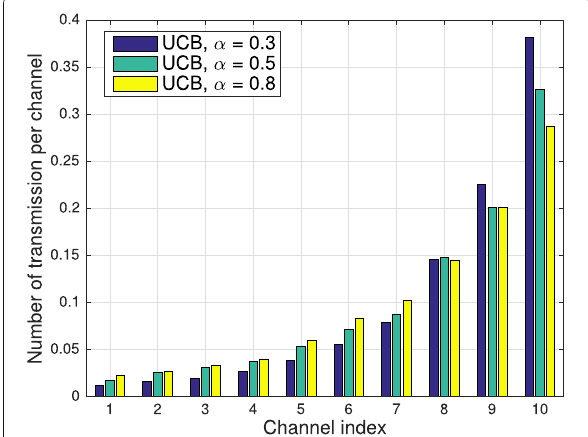
Fig. 12 Number of transmissions in each channel after 14 days of exploration. In the studied scenario, the probability of successful transmission in channel is (0.45, 0.53, 0.57, 0.64, 0.70, 0.77, 0.82, 0.87, 0.92, 0.96)